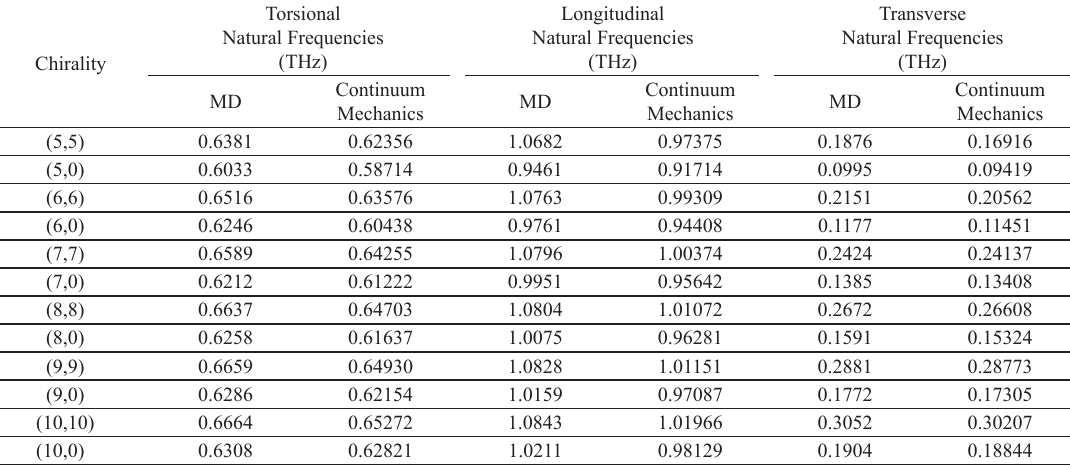
Table 2. Comparison between torsional, longitudinal and transverse vibration frequencies (THz) of SiNT with 5nm length predicted by continuum mechanics and molecular dynamics simulation for different chirality and diameters.